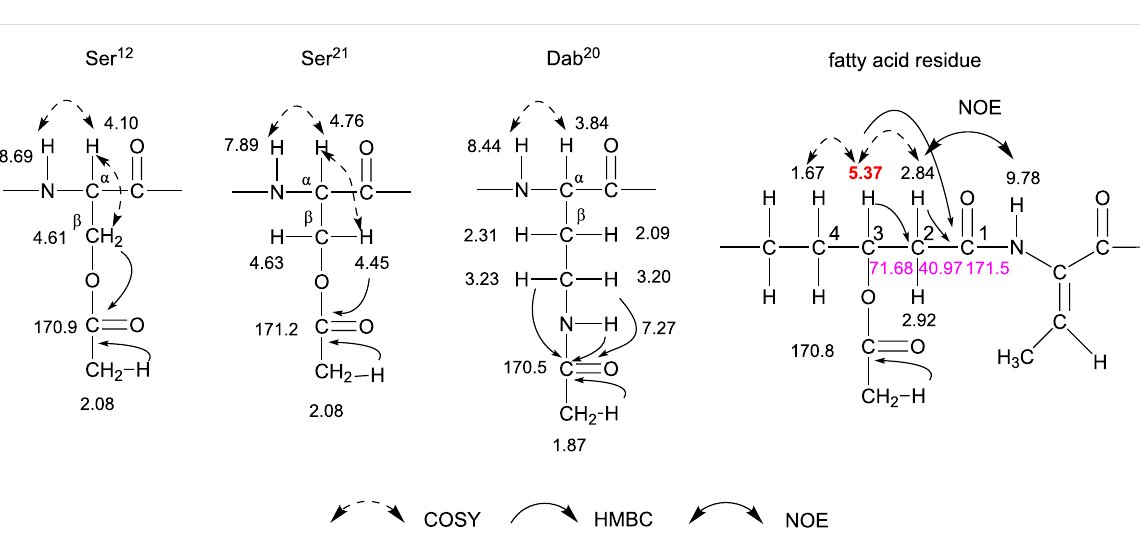
residues were acetylated in the tetraacetate, and the amino group of Dab was acetylated in both the monoacetate and the tetraacetate. We found that the hydroxy group at C-3 of the FA residue was acetylated despite the H-3 proton not having a clear HMBC cross peak with the acetyl carbonyl carbon. The δ H